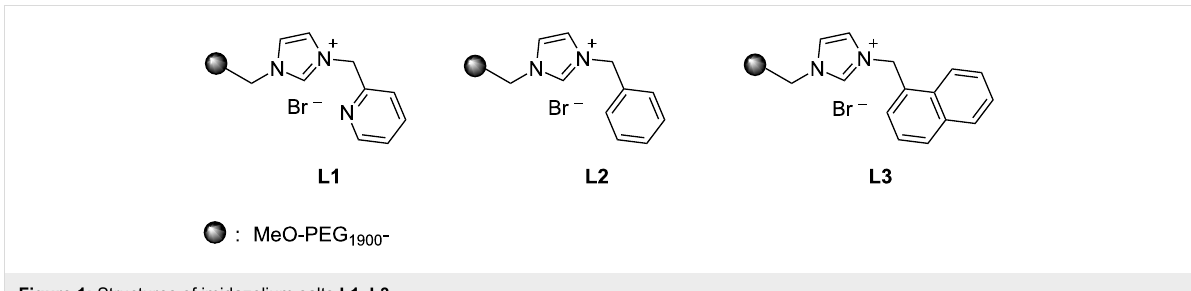
Figure 1: Structures of imidazolium salts L1 – L3